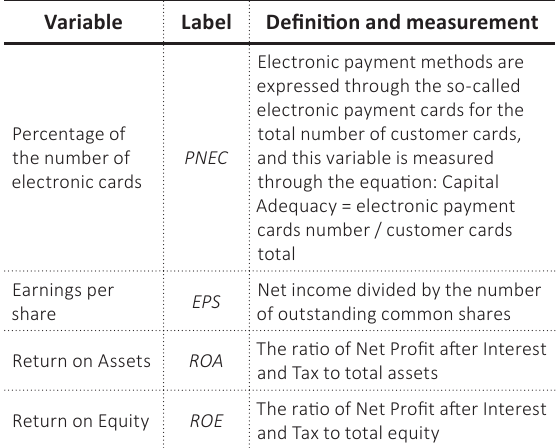
Table 1. The labels and measurement of variables